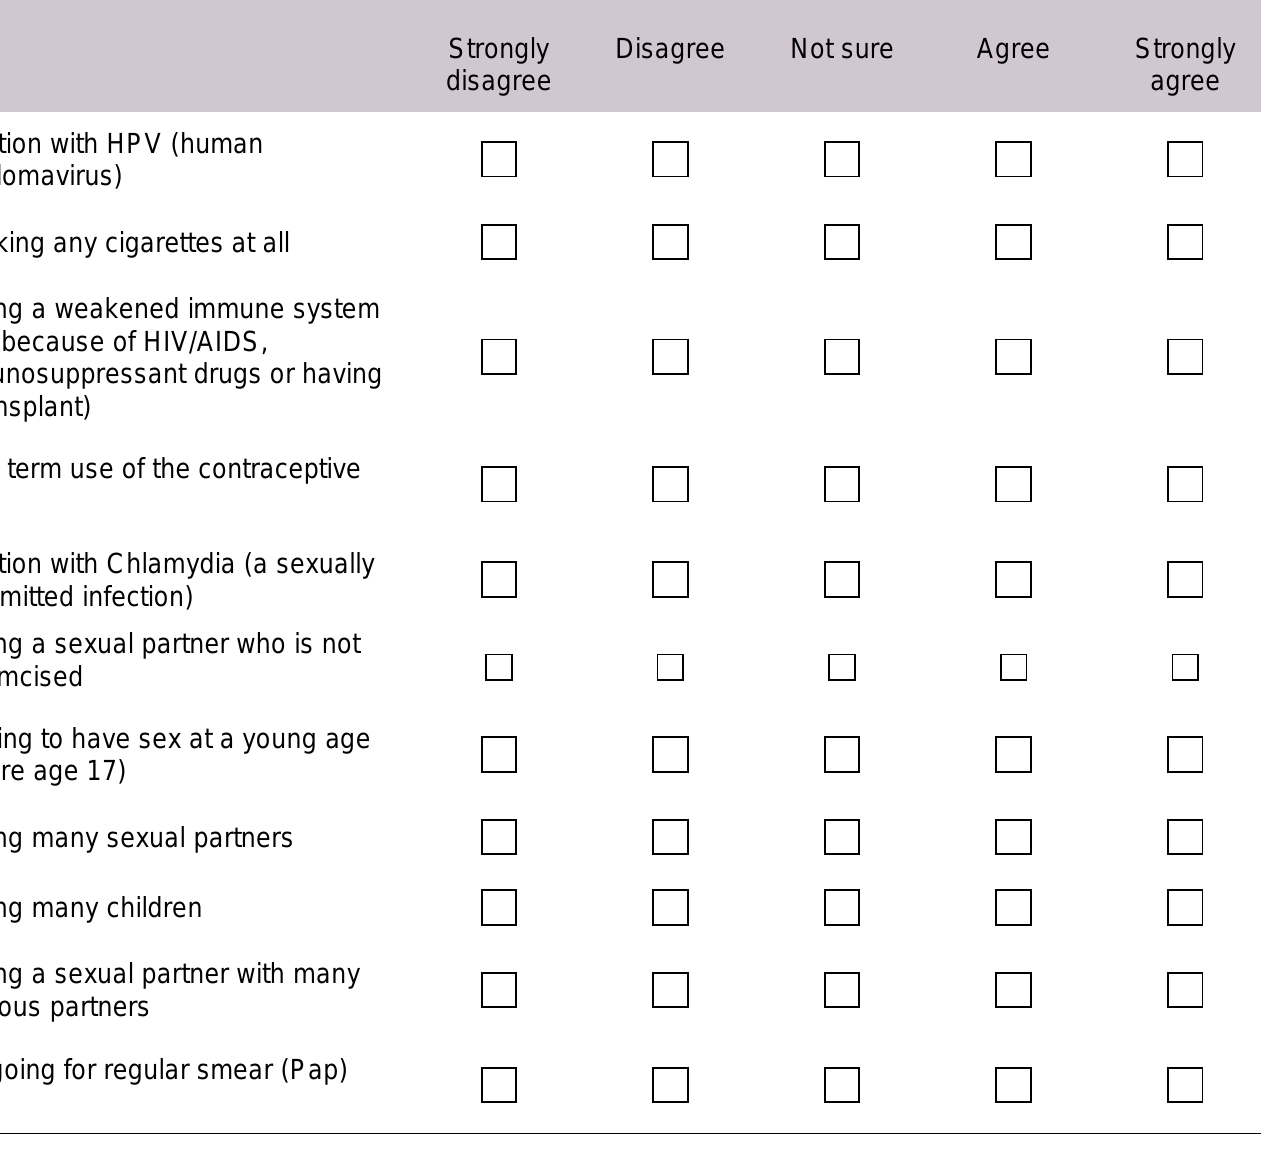
Cervical Cancer Awareness Measure Toolkit Version